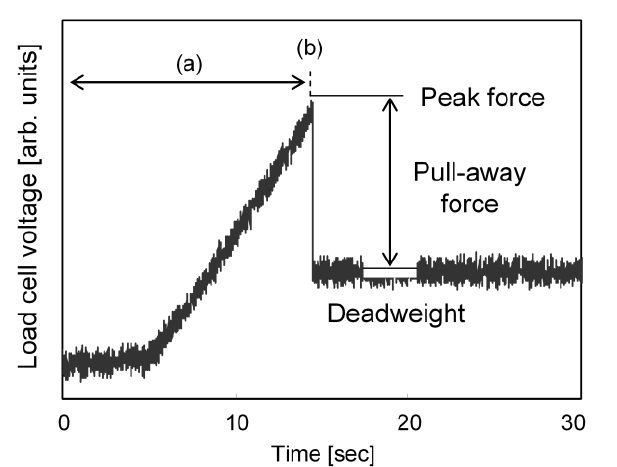
Fig. 5 A typical example of an actual output signal of the load cell during pull-away force measurement between a UHMWPE pin and the Co-28Cr-6Mo alloy disk. The disk specimen is pulled away within (a), and the pin and disk specimens are separated at